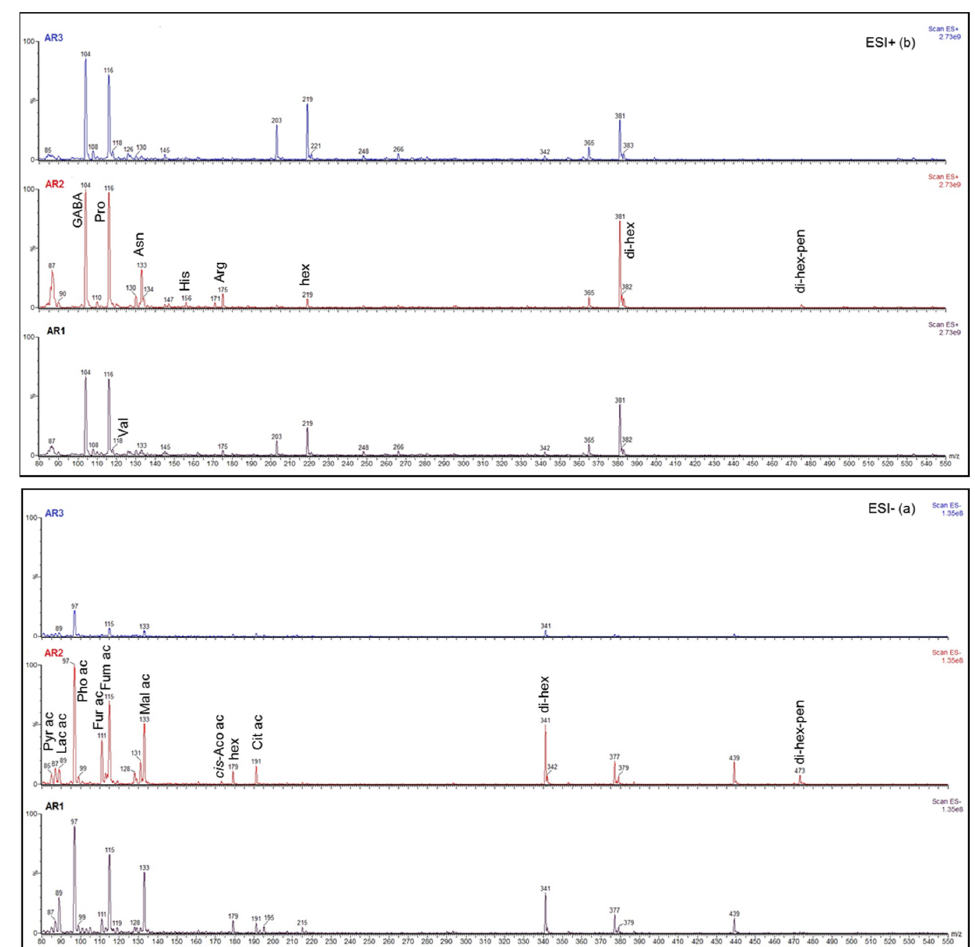
Figure 1. ESI-MS/MS profile of rhizome Agropyron repens herbal tea, samples AR1, AR2, AR3, in negative ionization ESI- ( a ) and positive ionization ESI+ ( b ), with signals normalized to the highest one for a direct comparison among samples. ( a ) Pyr ac (pyruvic acid, [M-H] − = 87 m / z